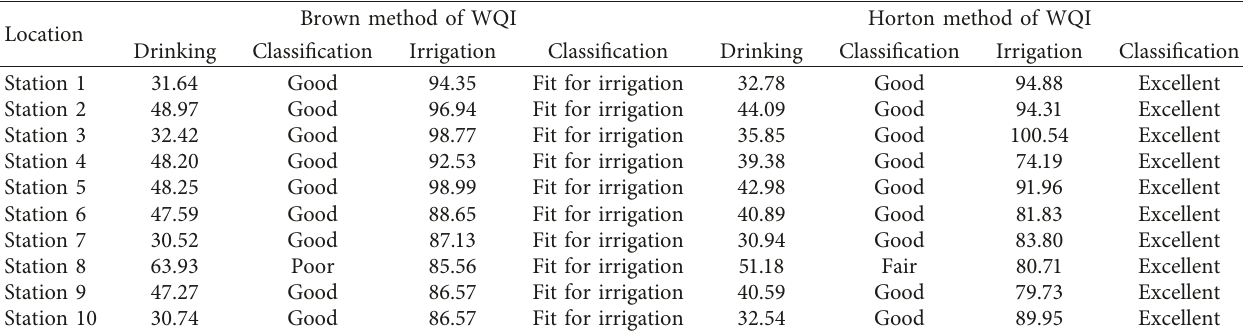
Table 3: Brown and Horton method of WQI of the water samples.